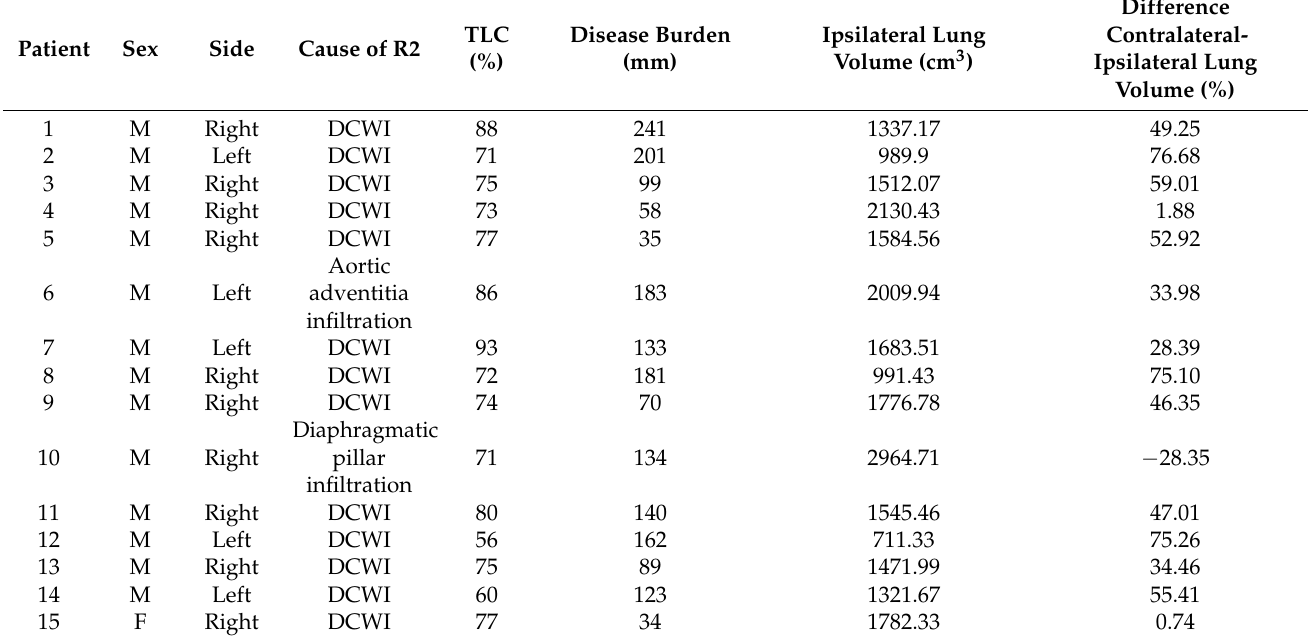
Table 2. Characteristic of 15 patients who underwent exploratory